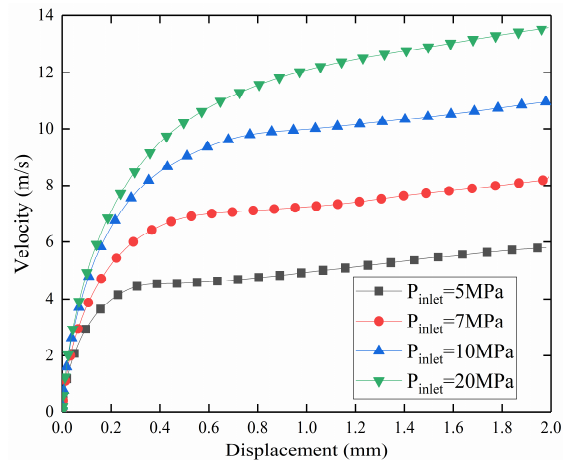
Figure 18. Velocity of the valve spool for different inlet pressures.